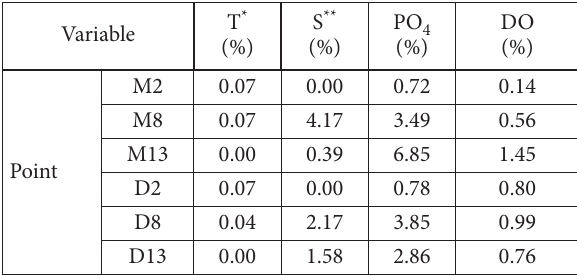
Table 5. Relative error at measuring points